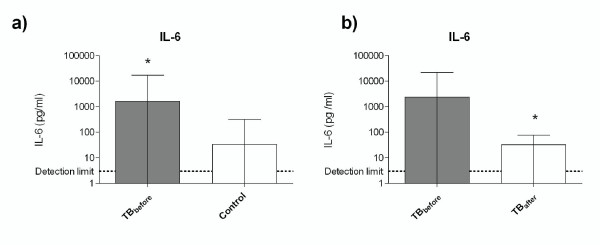
The levels of proinflammatory cytokine IL-6 were (a), significantly higher in TB patients compared with healthy controls (*p < 0.0001), and (b) significantly reduced in TB patients after treatment (TBafter) compared with before started treatment (TBafter). The IL-6 levels are given as means ± standard deviation (SD).